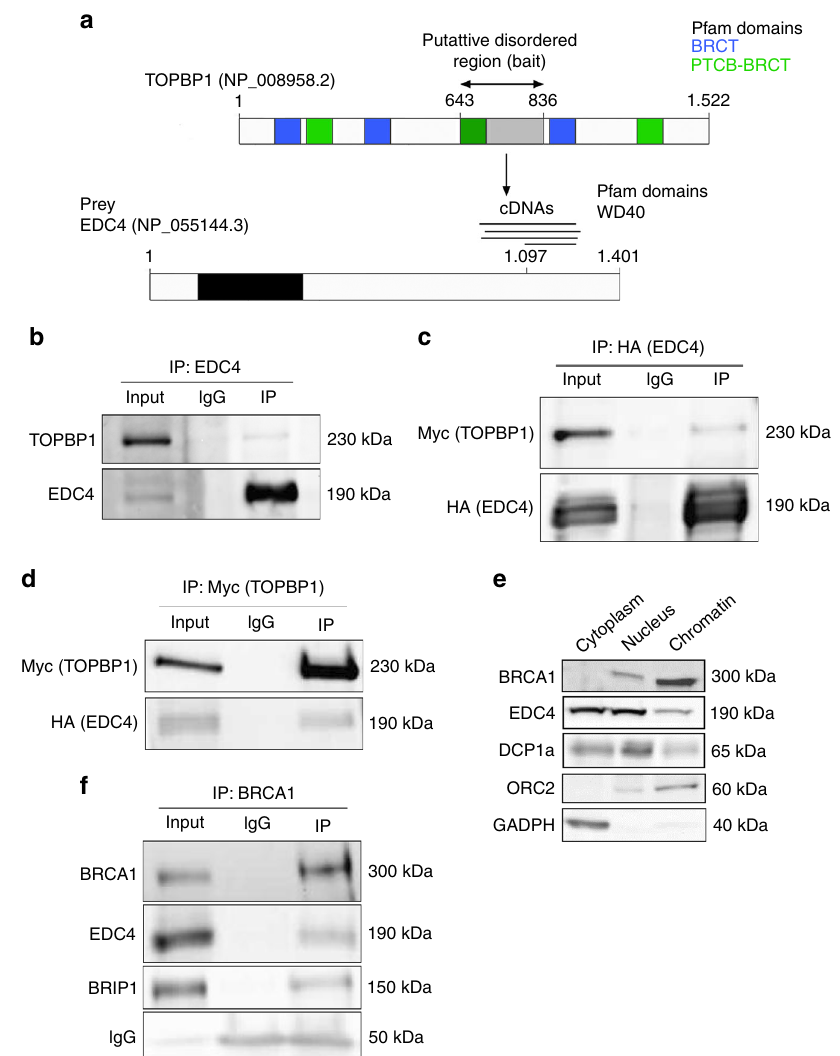
Fig. 1 EDC4 interacts and with the BRCA1-BRIP1-TOPBP1 complex. a Diagram showing the region of TOPBP1 used as bait for the Y2H screen and the different cDNAs from EDC4 captured. b Immunoblots showing that endogenous EDC4 interacts with TOPBP1 in HeLa cells. EDC4 was immunoprecipitated and analyzed by immunoblotting with indicated antibodies. c Immunoblots showing that exogenous EDC4 interacts with exogenous TOPBP1 in HeLa cells. EDC4 was immunoprecipitated from HeLa cells expressing both tagged EDC4 and TOPBP1 and analyzed by immunoblotting with indicated antibodies. d Immunoblots showing that exogenous TOPBP1 interacts with exogenous EDC4 in HeLa cells. TOPBP1 was immunoprecipitated from HeLa cells expressing both tagged EDC4 and TOPBP1 and analyzed by immunoblotting with indicated antibodies. e Cellular fractionation of HeLa cells shows that EDC4 is not only a cytoplasmatic protein but also present at the nucleus and the chromatin. f Immunoblots showing that endogenous EDC4 interacts with BRCA1 and BRIP1 in HeLa cells. BRCA1 was immunoprecipitated from HeLa cells and analyzed by immunoblotting with indicated